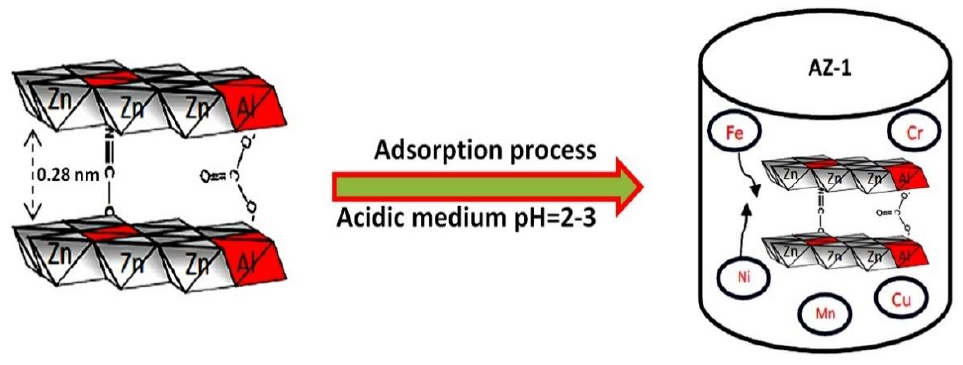
Figure 4. Adsorption process for purifying water containing heavy metals in an extremely acidic medium.